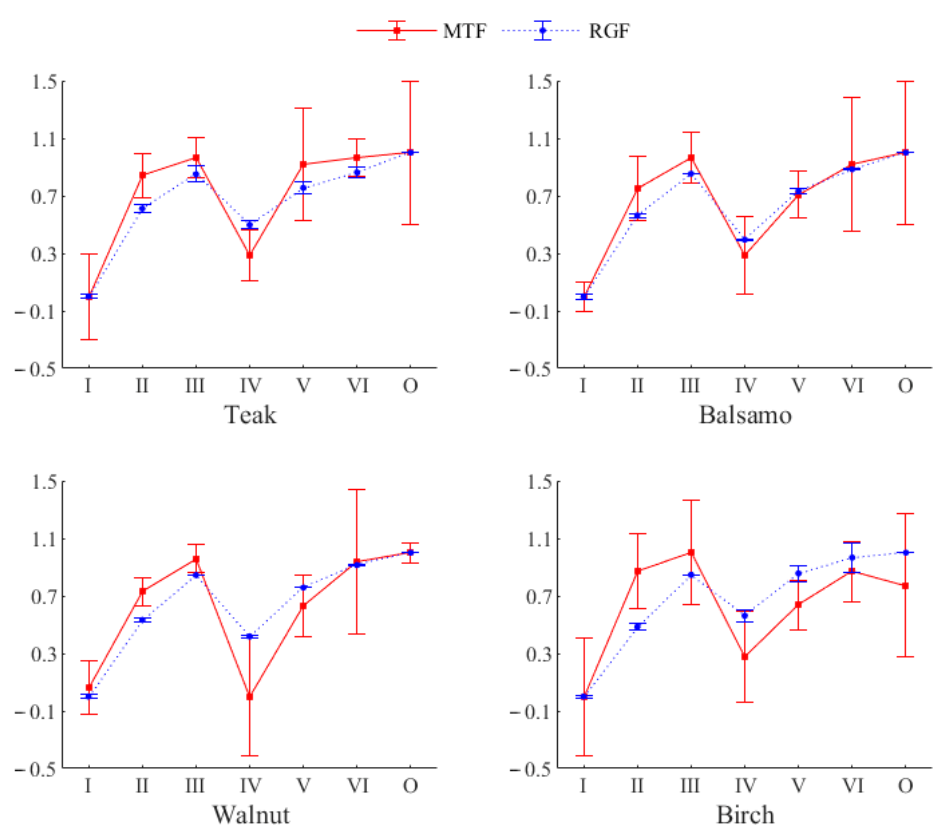
Figure 2. The changing trends of normalized MTF and RGF values under six denoising schemes. O represents original images.